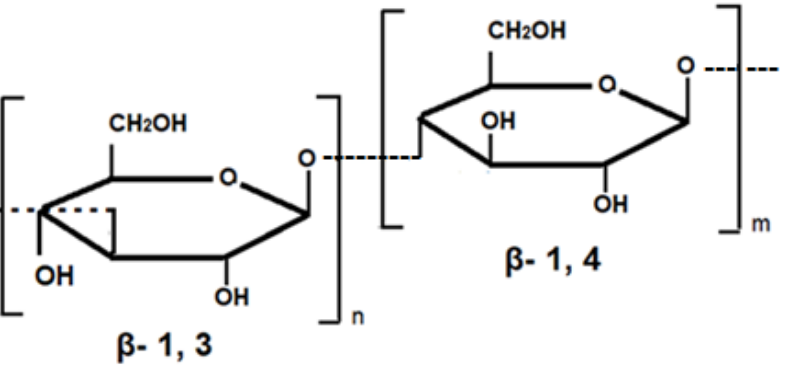
Figure 2. β -Glucans extracted from barley ( β -(1,3-1,4)- D Figure 2. β - Glucans extracted from barley (β -(1,3-1,4)- D -glucan.